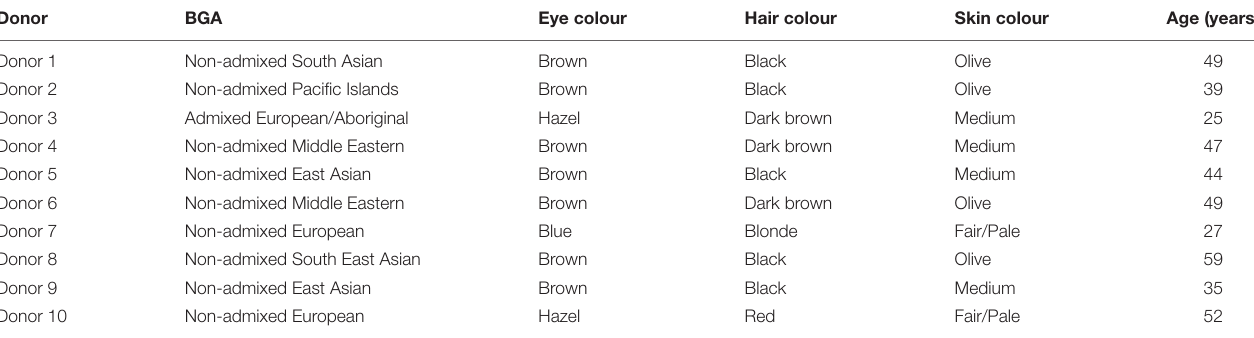
TABLE 1 | Donor’s self-declared biogeographical ancestry (BGA) and externally visible characteristics